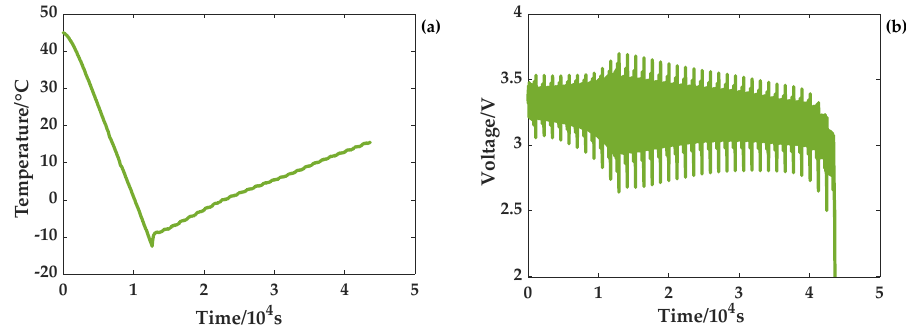
Figure 6. Temperature variation and voltage curve from the temperature drop experiment. ( a ) Tem- perature curve and ( b ) voltage curve.